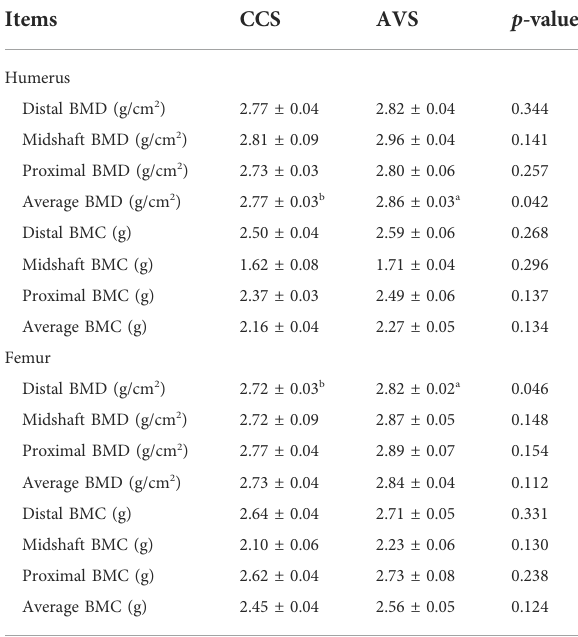
TABLE 3 Effect of rearing systems on mineral measurements of bones in aged laying hens (95 weeks of age) a . Items CCS AVS p-